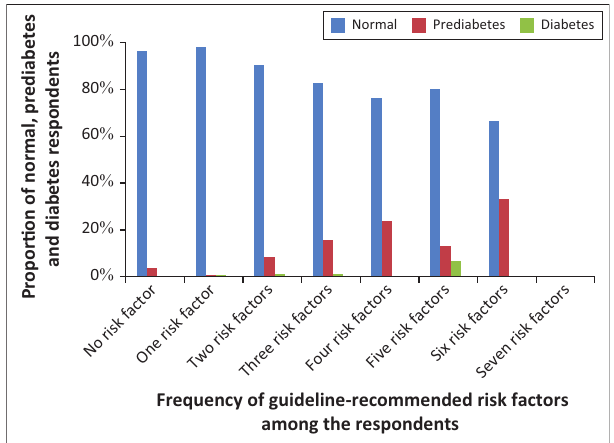
FIGURE 4: Proportion of prediabetes and diabetes based on the number of guideline-specific risk